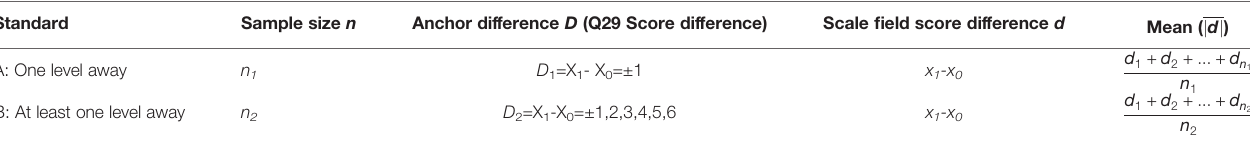
TABLE 1 | Calculation formula of MCID based on anchor